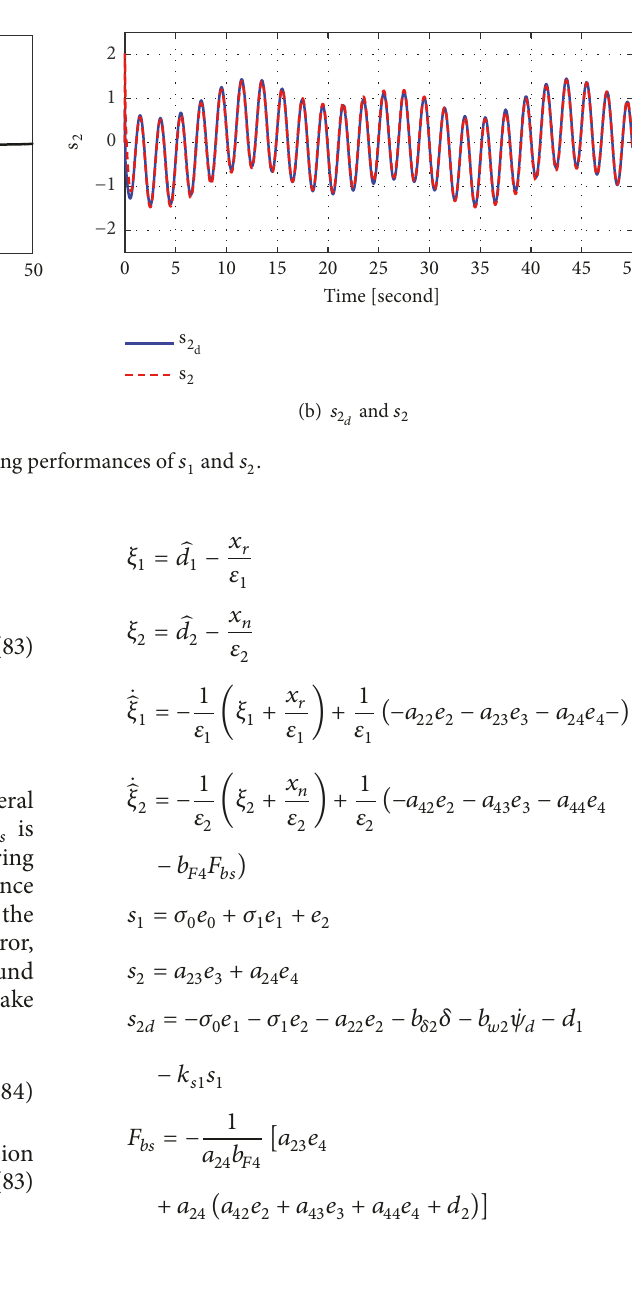
Figure 1: Estimated disturbances.